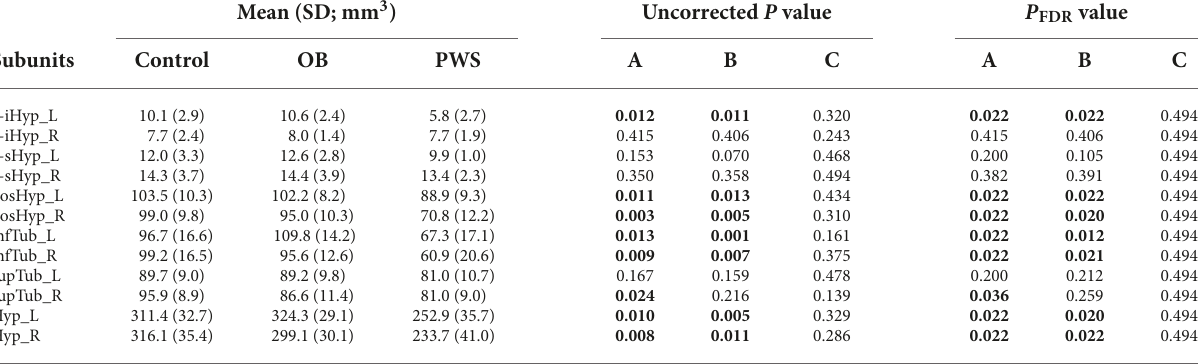
TABLE 3 Hypothalamic subunit volumes of each group and P value of group comparisons. Mean (SD; mm 3 ) Uncorrected P value P FDR value Subunits Control OB PWS A B B C